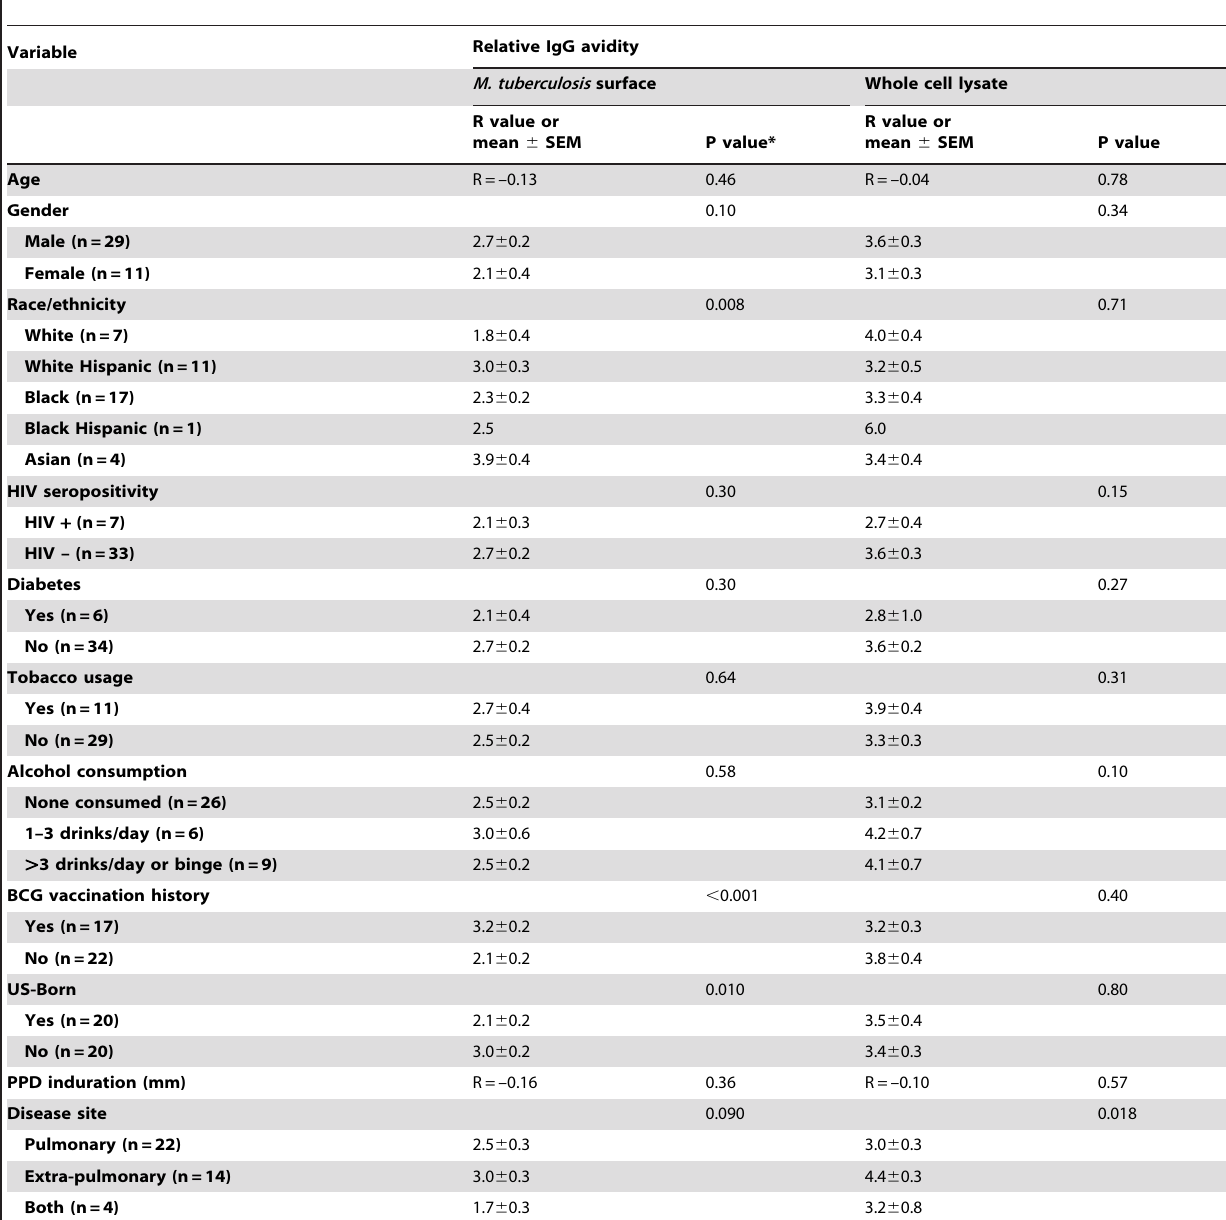
Table 3. Univariate correlation between clinical variables and relative IgG avidity of antibodies to the live M. tuberculosis surface or to whole cell lysate in patients with active TB disease